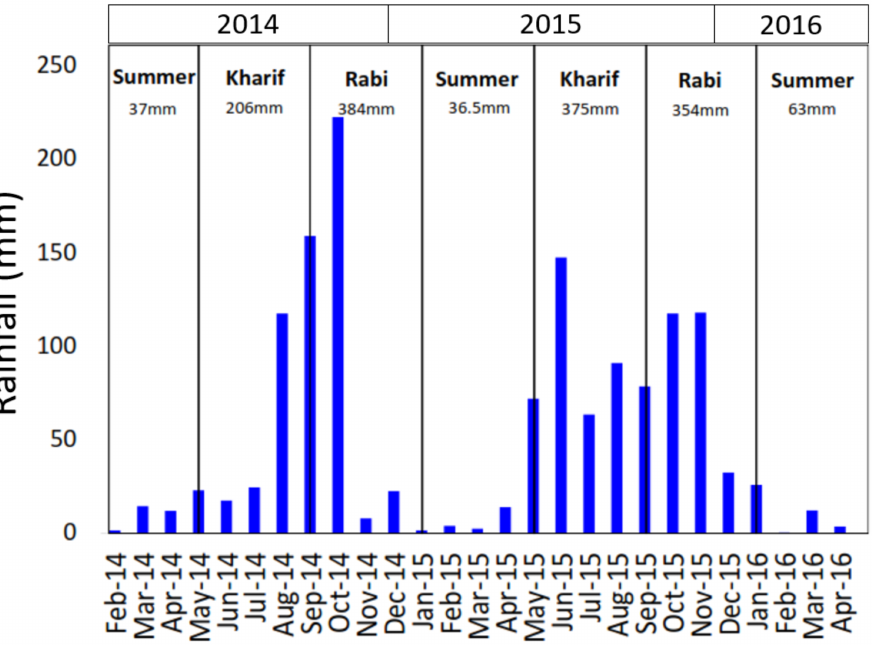
Figure 4. Monthly and seasonal rainfall representation during the various cropping seasons from